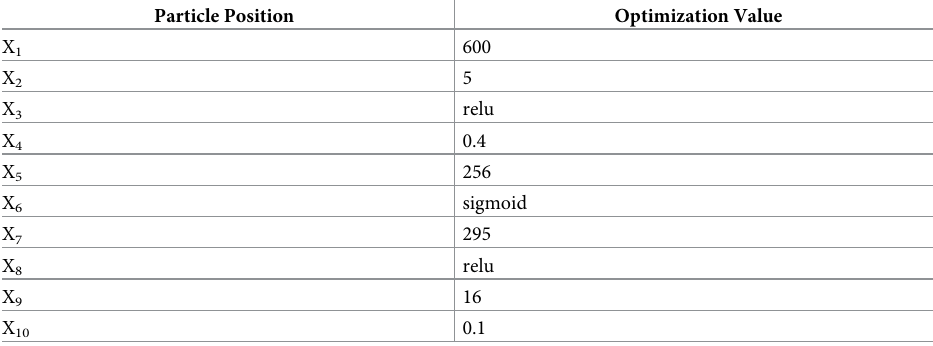
Table 4. CNN’s optimal hyperparameters utilizing the APSO–CNN algorithm. Particle Position Optimization Value